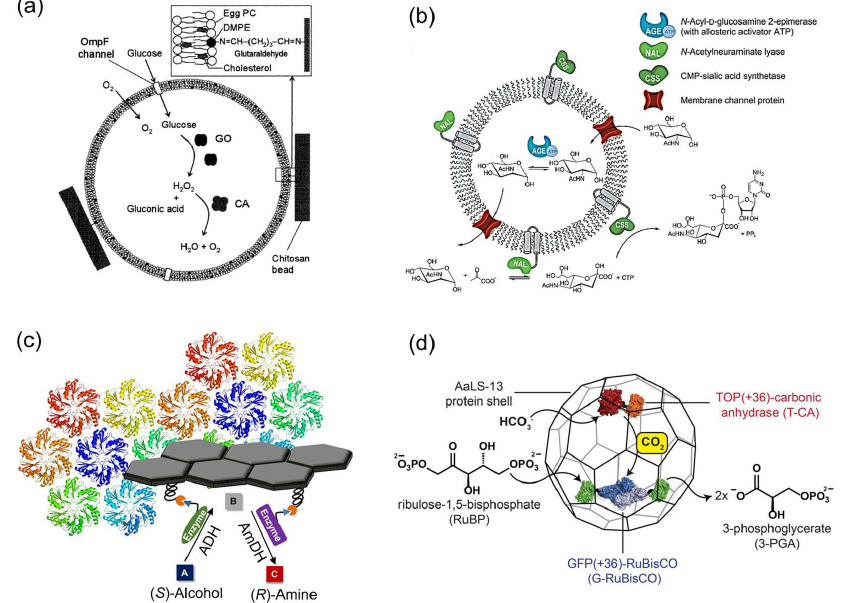
Figure 2. Enzymatic reactions on various carriers. ( a ) Schematic drawing of the liposome system containing entrapped glucose oxidase (GOx), catalase and membrane-embedded OmpF, which was immobilized into chitosan beads [47]. ( b ) Enzyme cascade reaction compartmentalized in a poly- mersome for the synthesis of CMP- N- acetylneuraminic acid (CMP-Neu5Ac). The N -Acyl-D-glu-